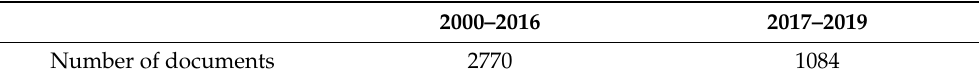
Table 4. The number of data according to years.